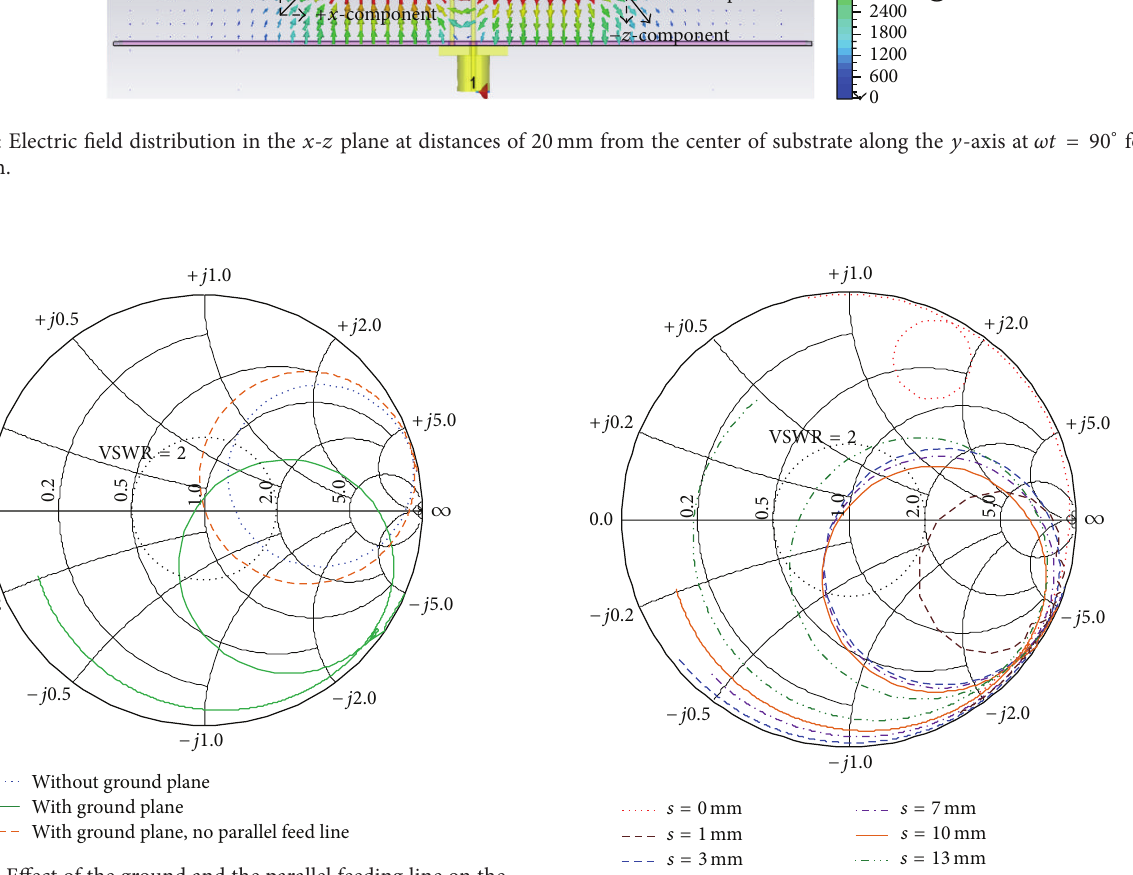
Figure 15: Effect of the ground and the parallel feeding line on the simulated input impedance characteristics. Figure 16: Simulated input impedance characteristics as a function